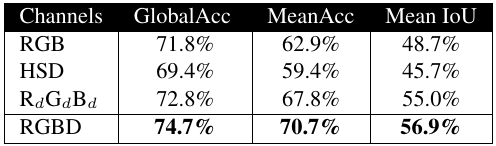
Table 8. Results on semantic labeling of structural elements of buildings in test T2 (10% of the dataset for training and 90% for